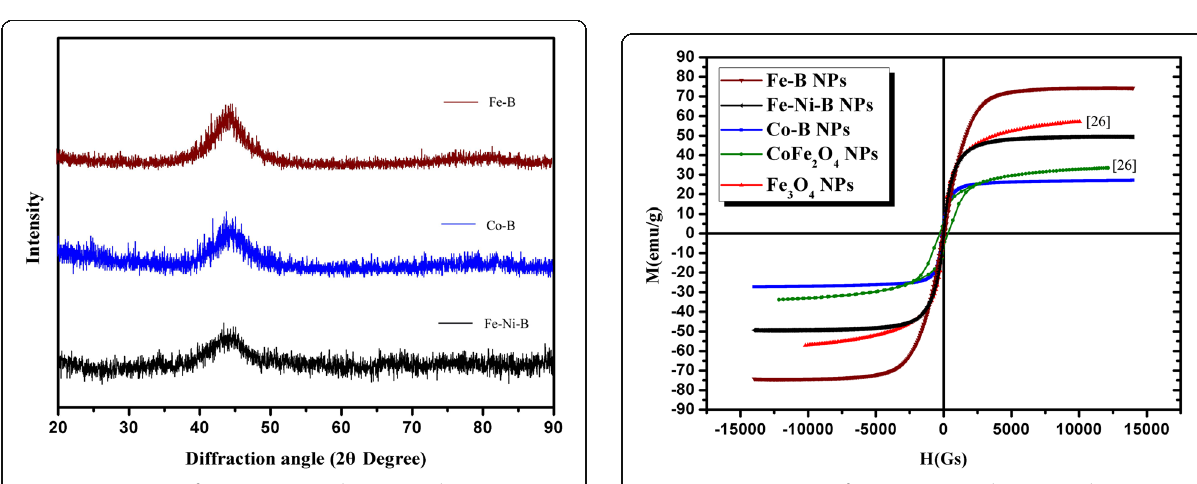
Fig. 3 Hysteresis curves of Fe-B, Fe-Ni-B, and Co-B